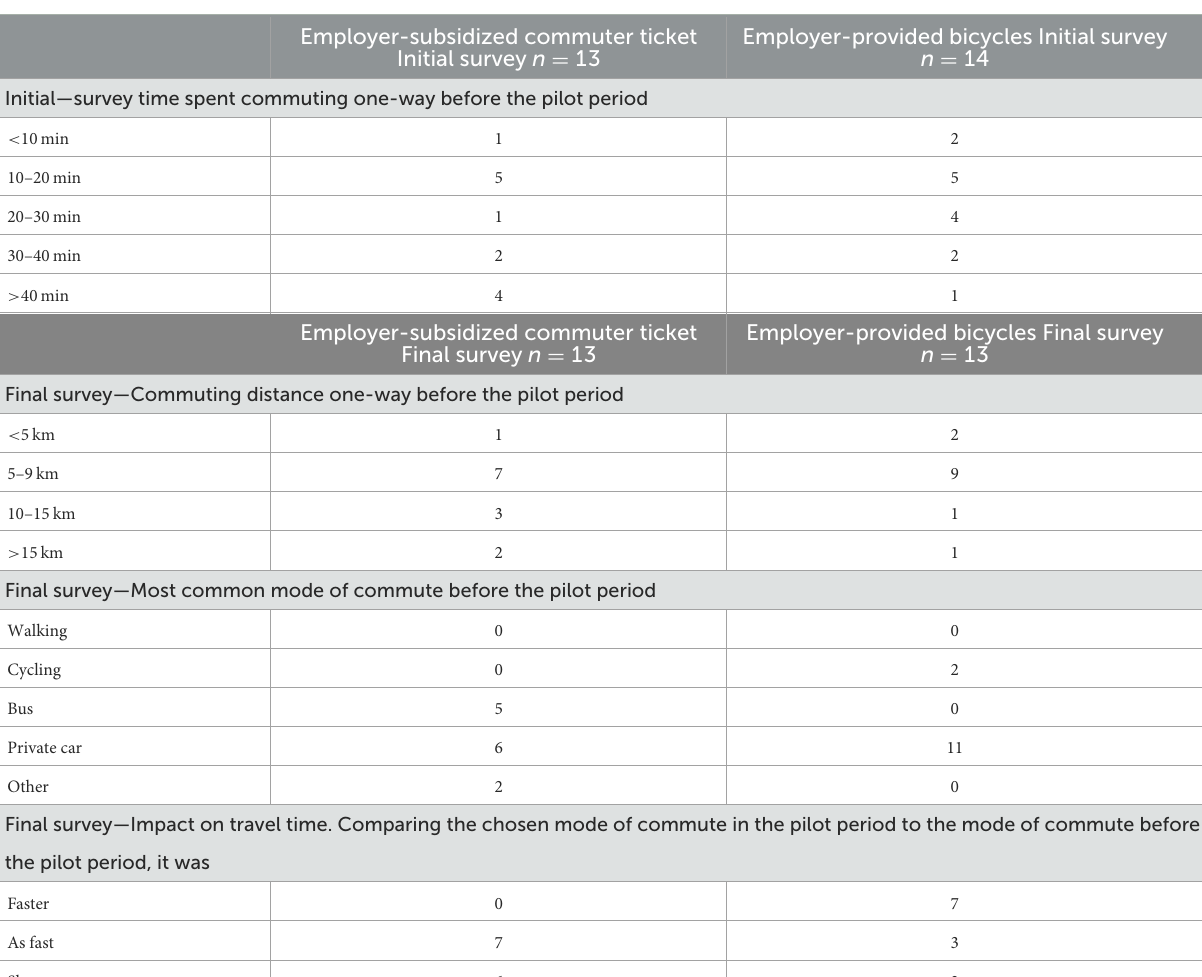
TABLE 2 Background information on commuting before the pilot period (time spent commuting one-way, commuting distance one-way and most common mode of commute before the pilot period) and the impact of the pilot period on participant’s travel time and wellbeing. Employer-subsidized commuter ticket Employer-provided bicycles Initial survey n = Initial survey n = 13